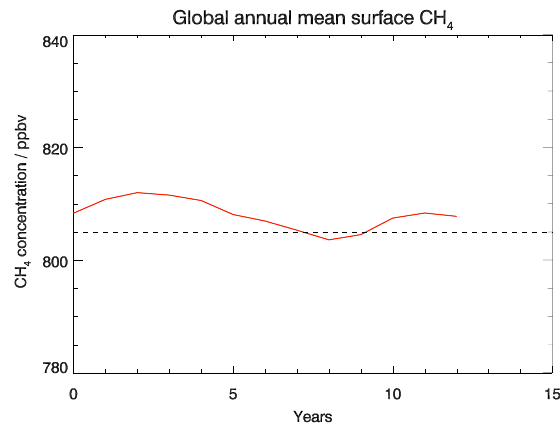
Fig. 5. Methane concentrations from the spin up of the chemistry components under 1860 conditions.